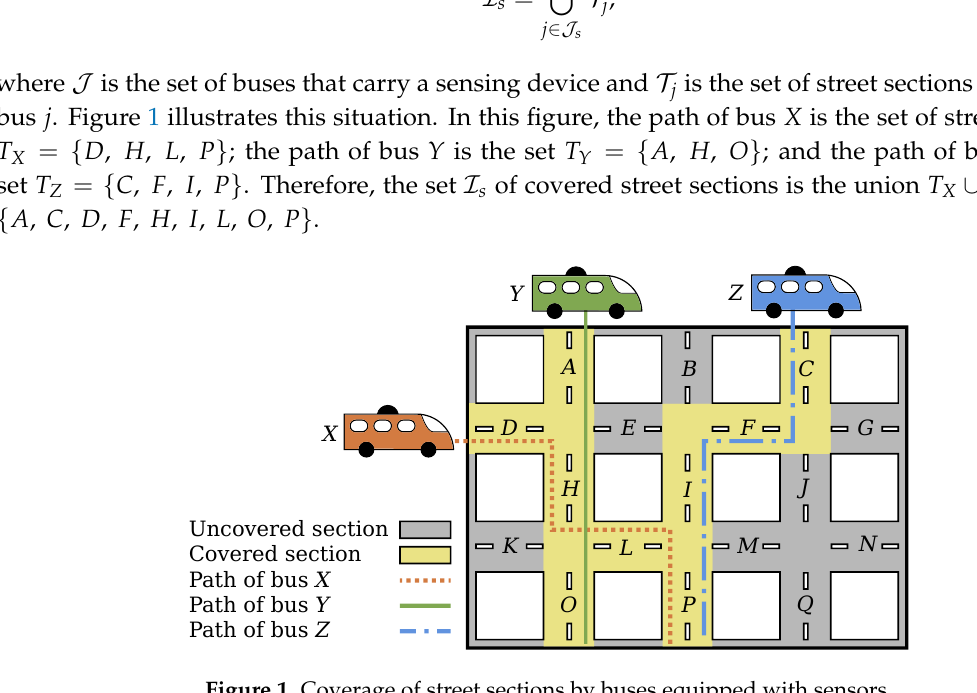
Figure 1. Coverage of street sections by buses equipped with